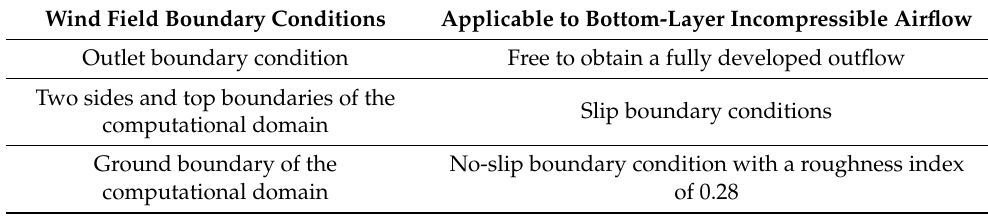
Figure 5. Models created in PHOENICS (A to C, from left to right). Table 4. Boundary